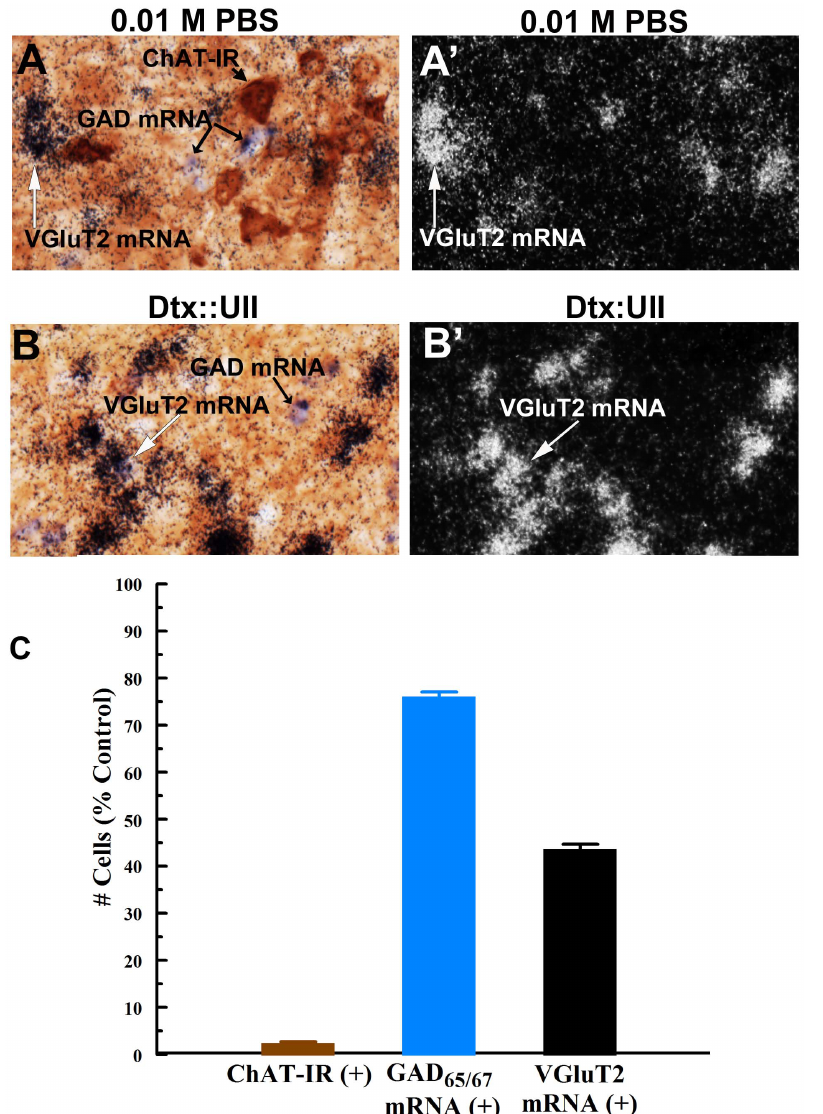
Figure 7. Dtx::UII infusion induced loss of PPTg glutamatergic and GABAergic cells. Panels A and B: Representative sagittal PPTg sections showing ChAT immunoreactive neurons (ChAT-IR; brown cells) and GAD 65/67 mRNA (purple cells) under bright field microscopy (left) and VGluT2 mRNA as white aggregates under epiluminescence microscopy (right) 14 days following unilateral PPTg infusion of vehicle (0.01 M PBS; A and A 9 ) and Dtx:UII (B and B 9 ) into the contralateral PPTg. Panel C: Numbers of cholinergic (ChAT), glutamatergic (VGluT2), and GABAergic (GAD 65/67 ) cells following unilateral PPTg infusion of Dtx:UII (left panels), expressed as a percentage of the number of each cell type counted in the contralateral hemisphere following vehicle infusion (n=3). Unilateral PPTg Dtx::UII infusion induced significant loss of cholinergic, glutamatergic, and GABAergic cells. Error bars represent 6 SEM.